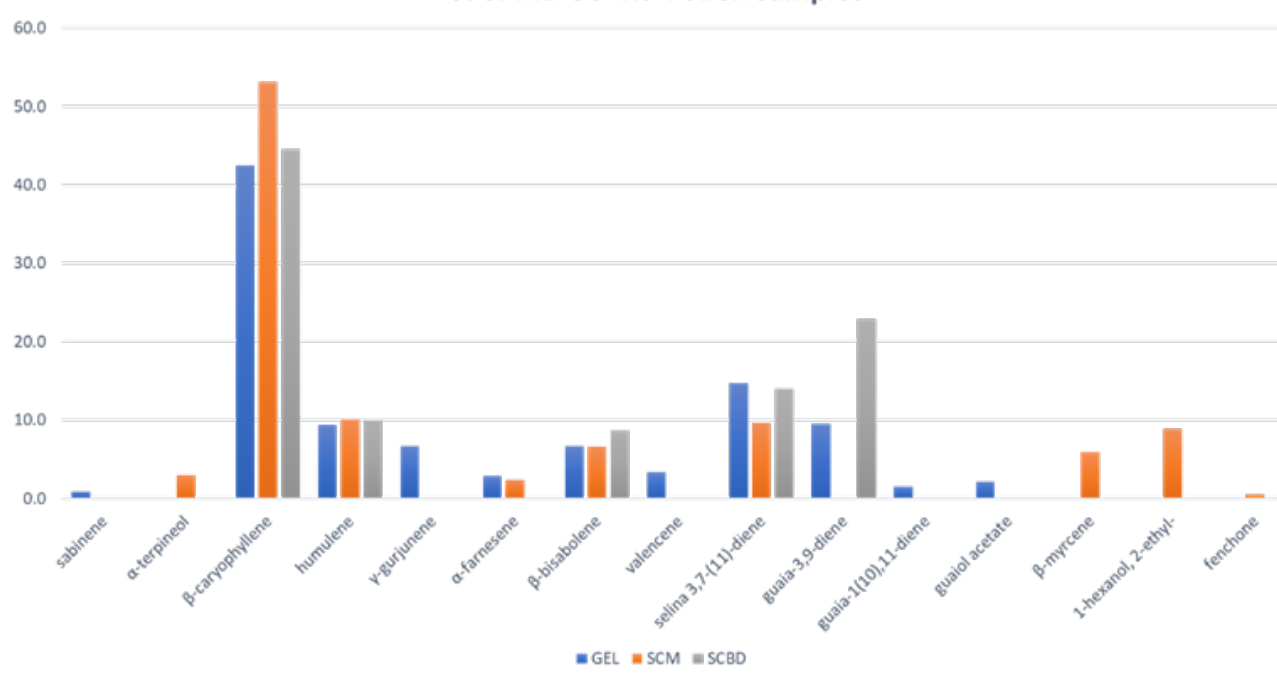
Table 2. Chemical composition (percentage mean value ± standard deviation) of Cannabis sativa L. pollen extracts.